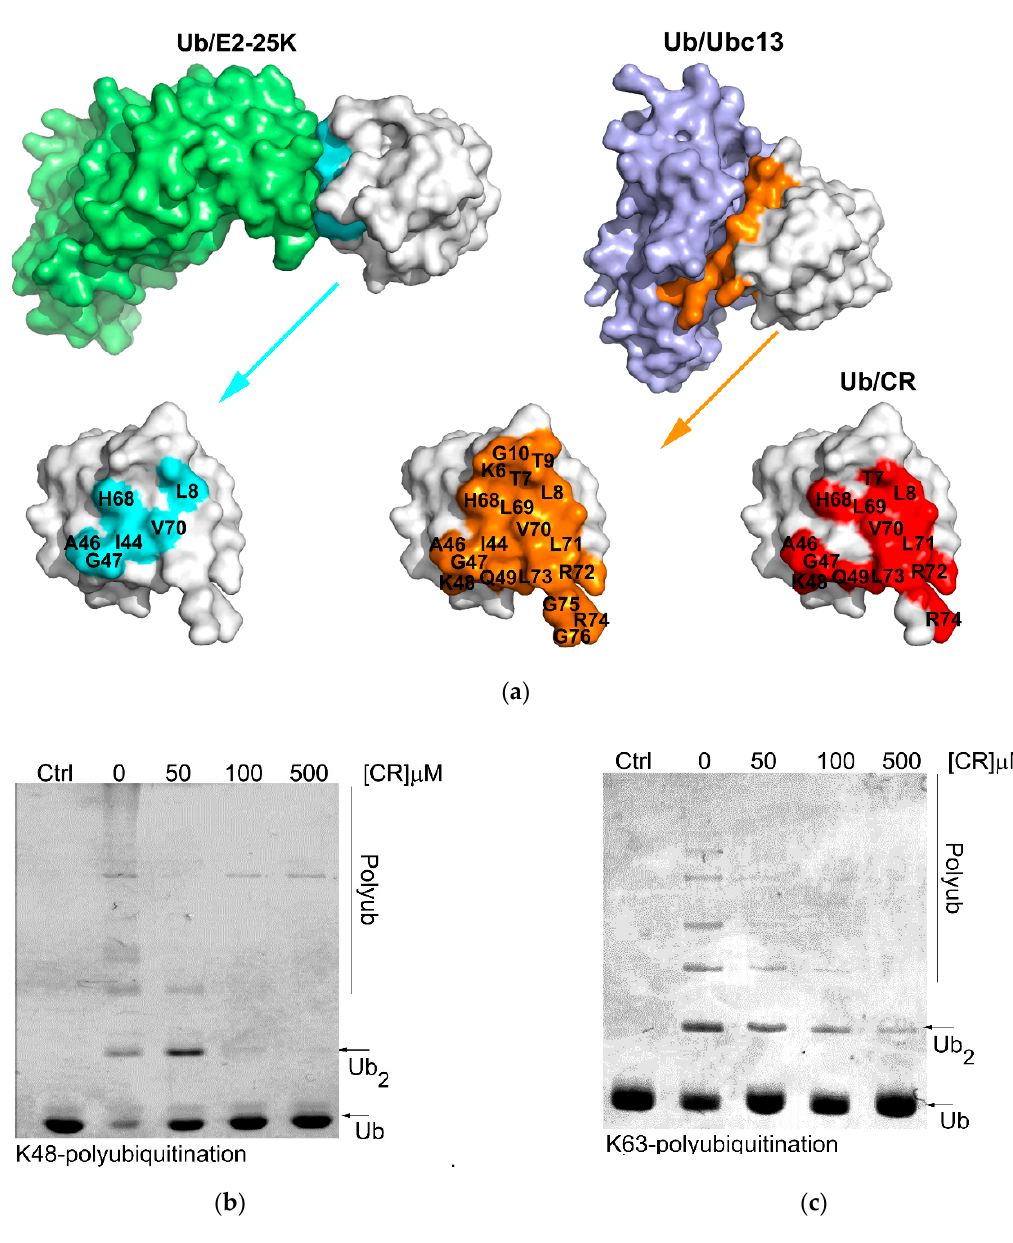
Figure 5. CR inhibits K48- and K63- polyubiquitination in vitro. ( a ) Interacting surface of ubiquitin when complex with E2-25K and Ubc13 compared with the surface used for CR binding. ( b , c ) CR inhibits K48- ( b ) and K63-ubiquitinations ( c ). First, mono ubiquitin was mixed with UBA1, E2-25K or complex Mms2/Ubc13, and 0–500 µ M CR in the presence or absence of ATP regeneration system. Then the mixture was incubated at 37 °C for 24 h. The reaction was stopped by adding 5X SDS loading buffer and the results were analyzed with 15% SDS-PAGE.